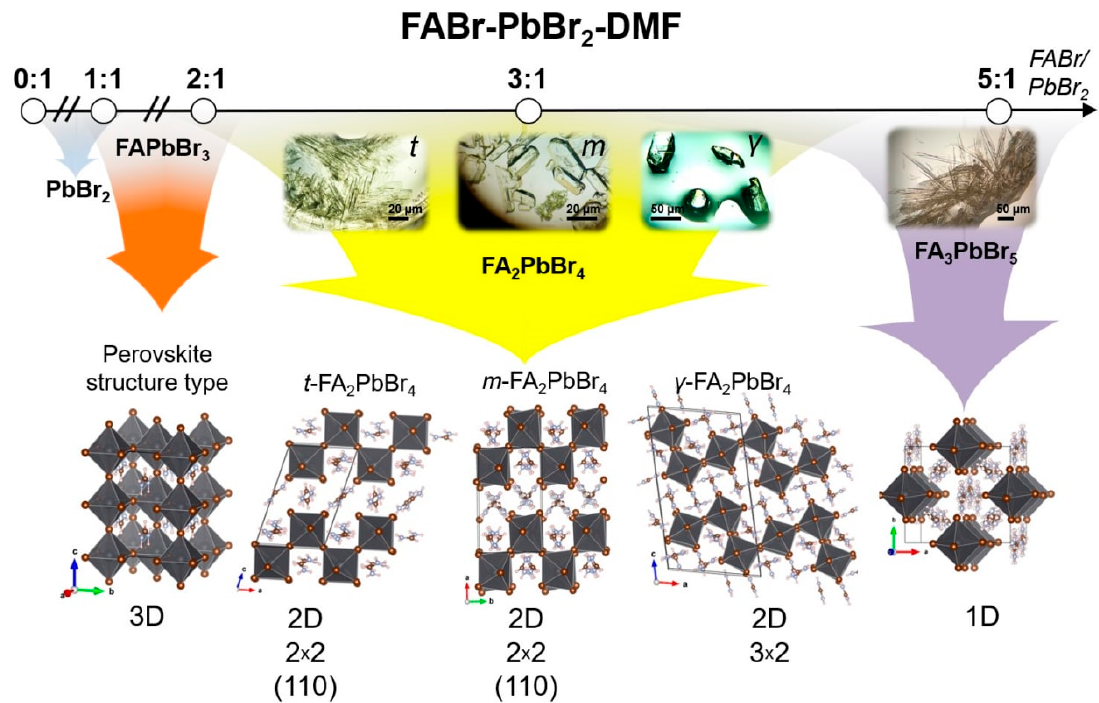
Figure 1. Phase diversity scheme of FABr-PbBr 2 -DMF system with different FABr:PbBr 2 ratios. The approximate regions of the phase coexistence fields are shown by overlapping colored arrows.